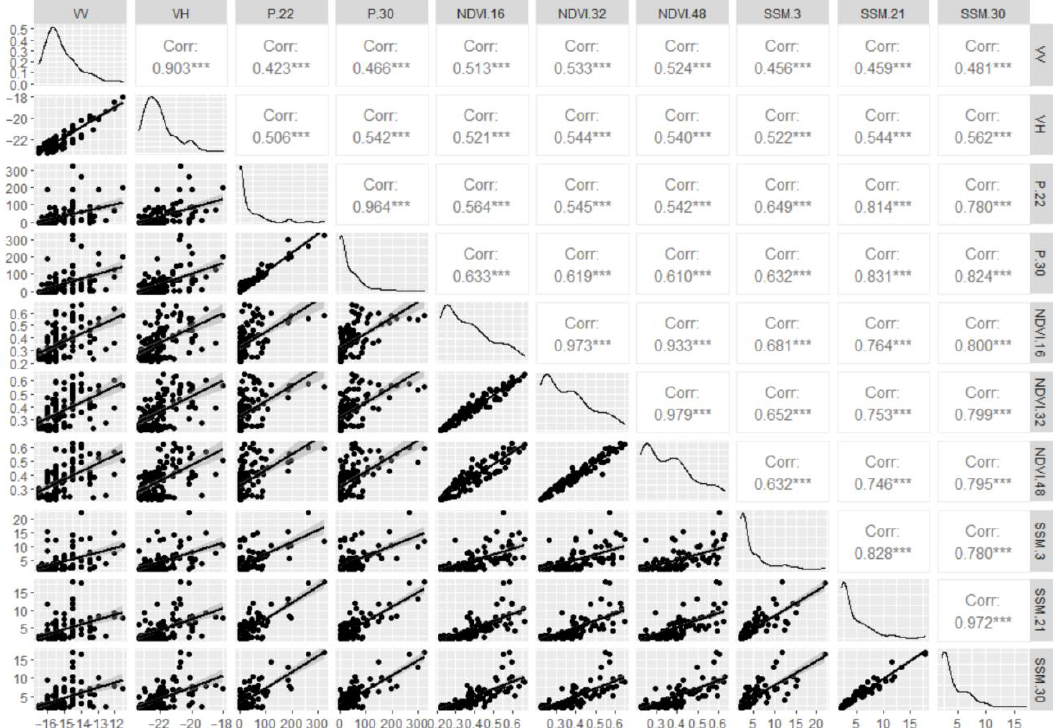
Figure 14. The correlation matrix of environmental variables, VV, and VH polarizations. Notes: charts on the matrix diagonal represent density distributions of values; charts on the top-right show linear correlation, characters “***” represent the significance of correlation at p < 0.001; charts on the bottom-left side present graphical scatter plots and linear regression models.